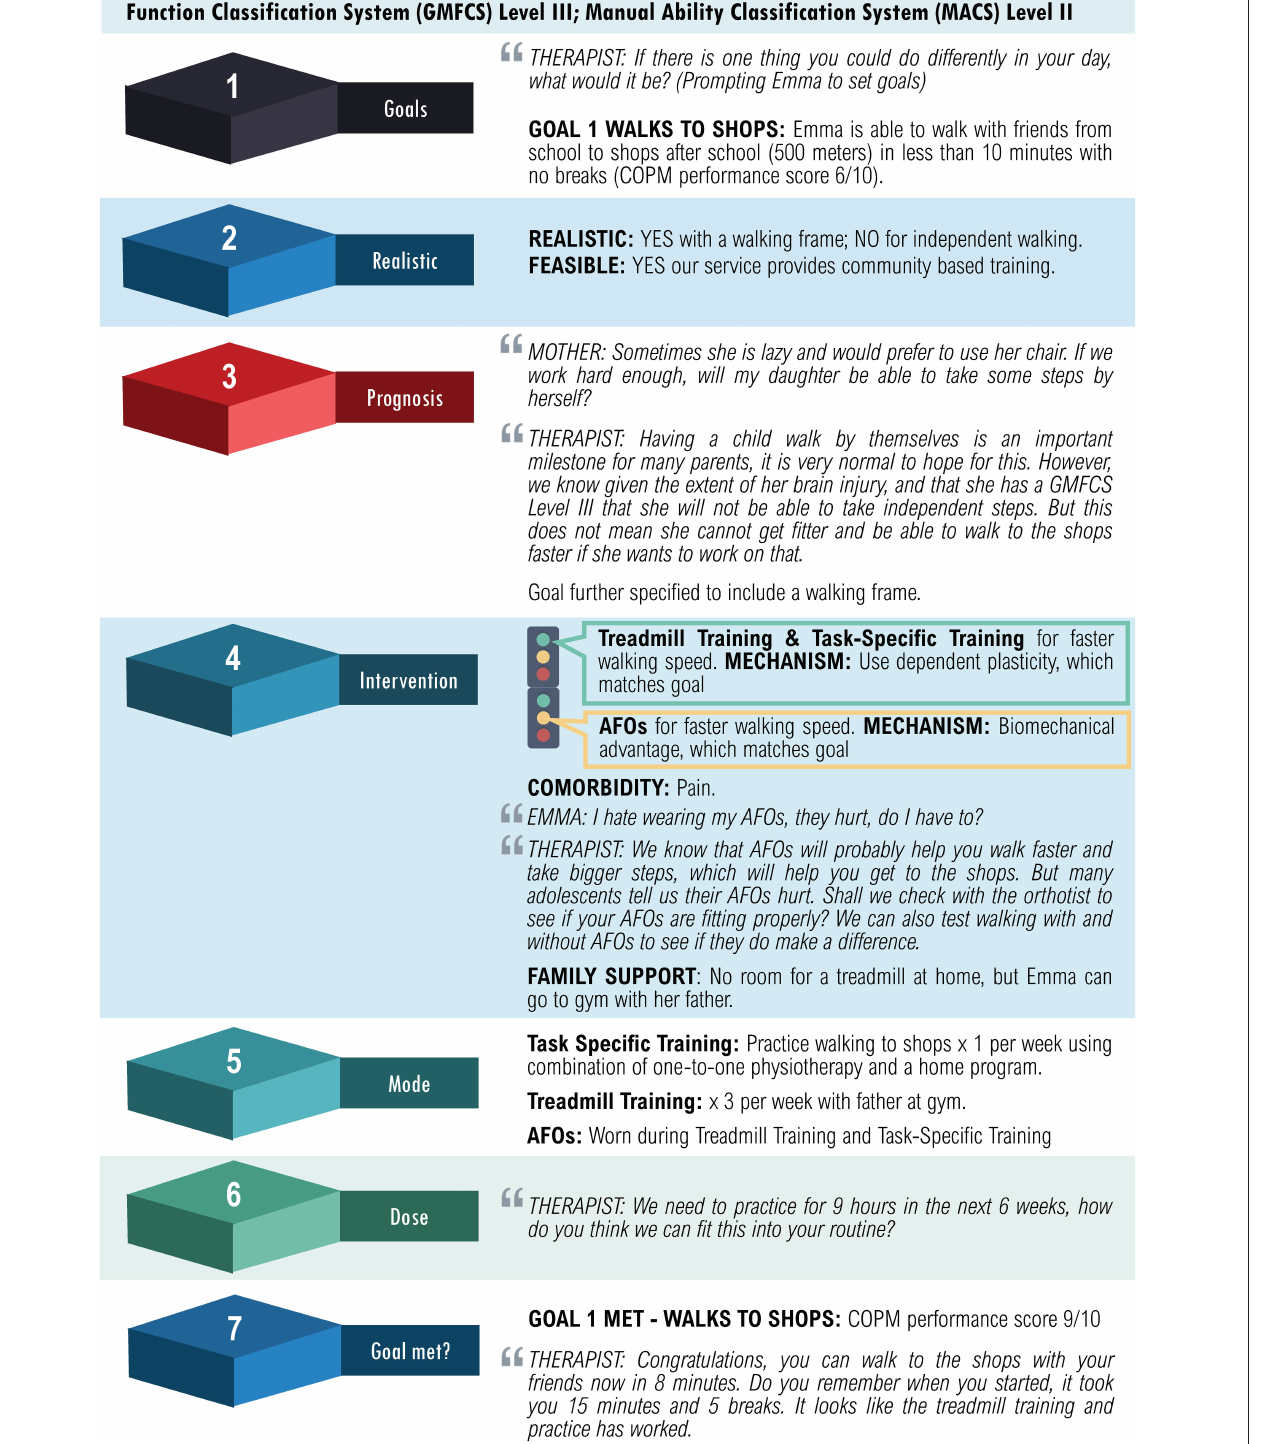
FIGURE 2 | Case study of an adolescent with cerebral palsy using the READ model.